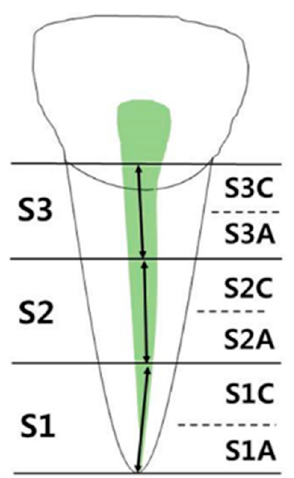
Figure 4. Axial level of the root canal